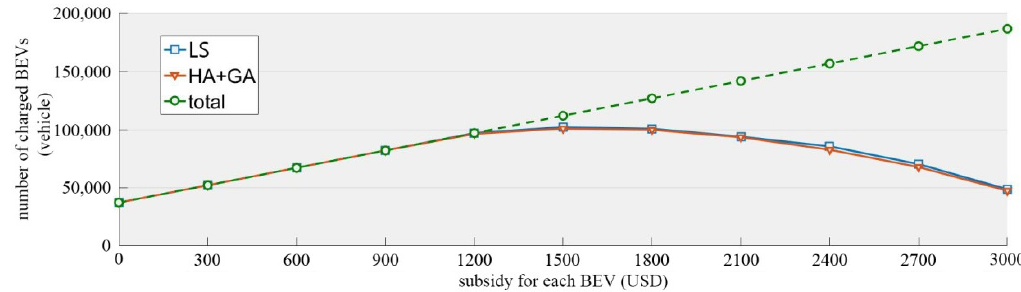
Figure 17. The results of the two algorithms under different subsidies.